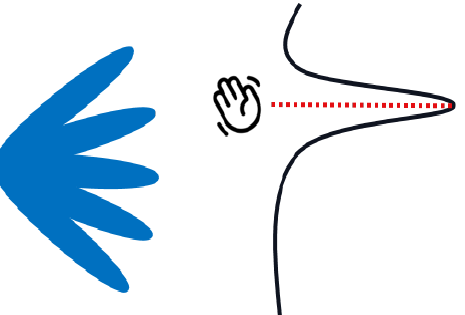
Figure 4. Fourier beam steering.